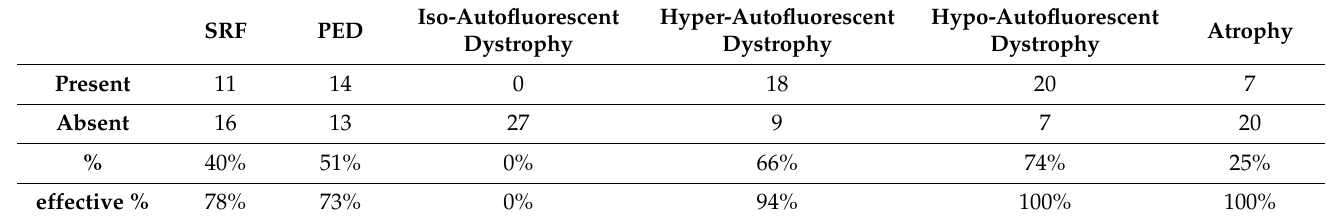
Table 2. Summary of outer retinal features detected by fundus autofluorescence (FAF) for the characterization of our study population. Percentage (%) is described as the ratio between the number of eyes in which the feature was detected over the total number of eyes examined. Effective % describes the ratio between the number of eyes in which FAF was able to identify the feature and the number of eyes in which multimodal imaging could detect the feature, thus the % of accordance between FAF and multimodal imaging accuracy in identifying the feature.